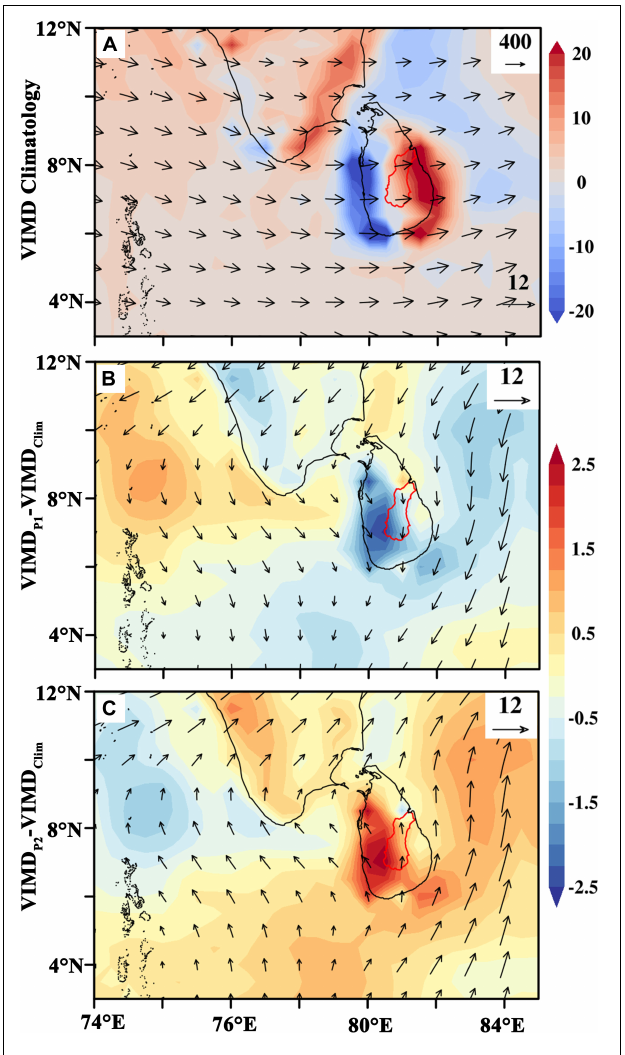
FIGURE 9 | Vertically integrated moisture flux divergence (VIMD, shaded, Unit: 10 - 6 kg m - 2 s - 1 ), superimposed with vertically integrated moisture transportation vector (Arrows, Unit: kg m - 1 s - 1 ) during southwest monsoon season (A) Climatology averaged over 1985–2015; (B) Anomalies for P 1 period (1985–1999) and (C) Anomalies for P 2 period (2000–2015) from the climatology. The reference arrow for moisture transport vector is 400 kg m - 1 s - 1 for the climatology and 12 kg m - 1 s - 1 for anomalies.